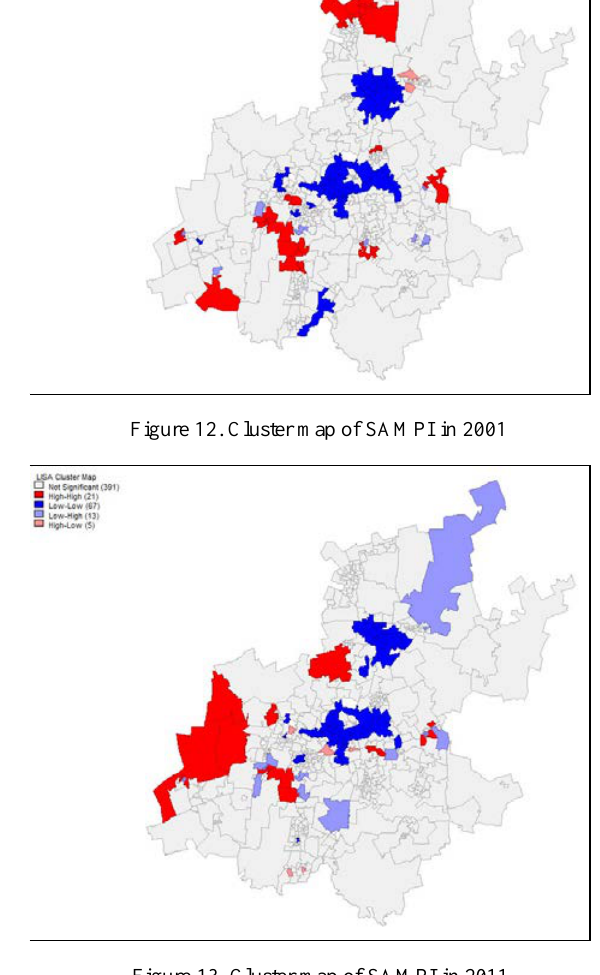
Figure 13. Cluster map of SAMPI in